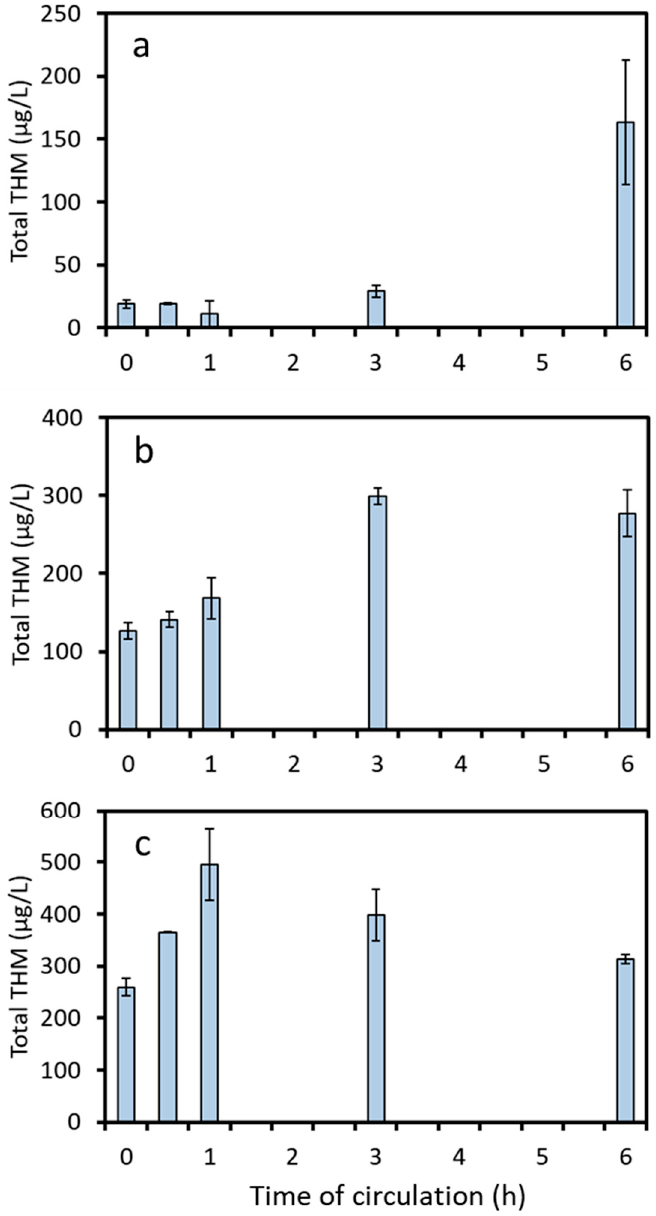
Figure 4. Total THM after 1 h of incubation in system S5 ′ s recirculated water with ( a ) 5, ( b ) 25, and ( c ) 50 mg/L chlorine.